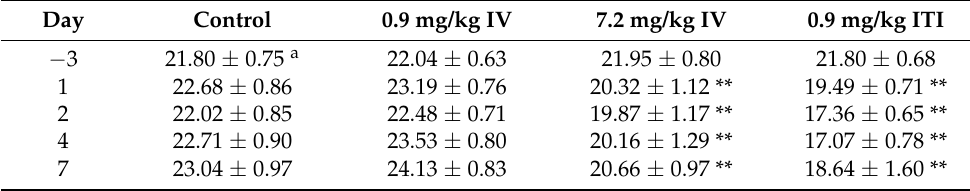
Table 1. Mean body weight of PHMG-P-treated mice.